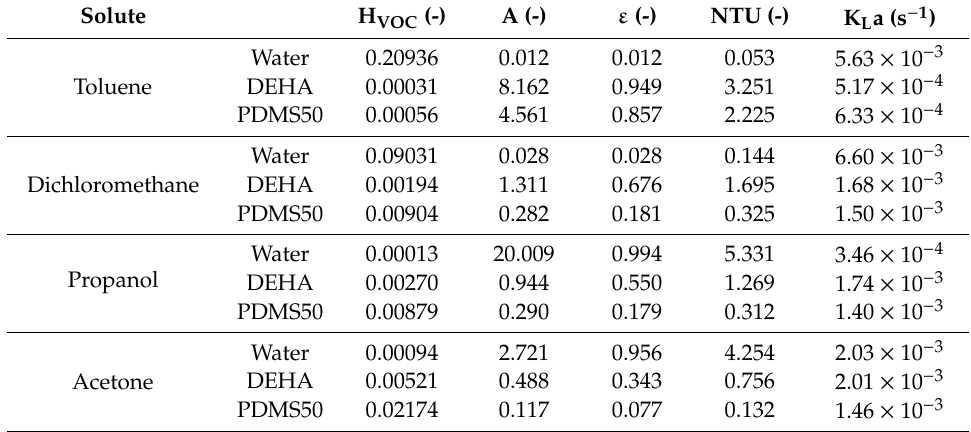
Table 3. K L a determination using the data reported in Biard et al. [1]. For all the simulations: gas